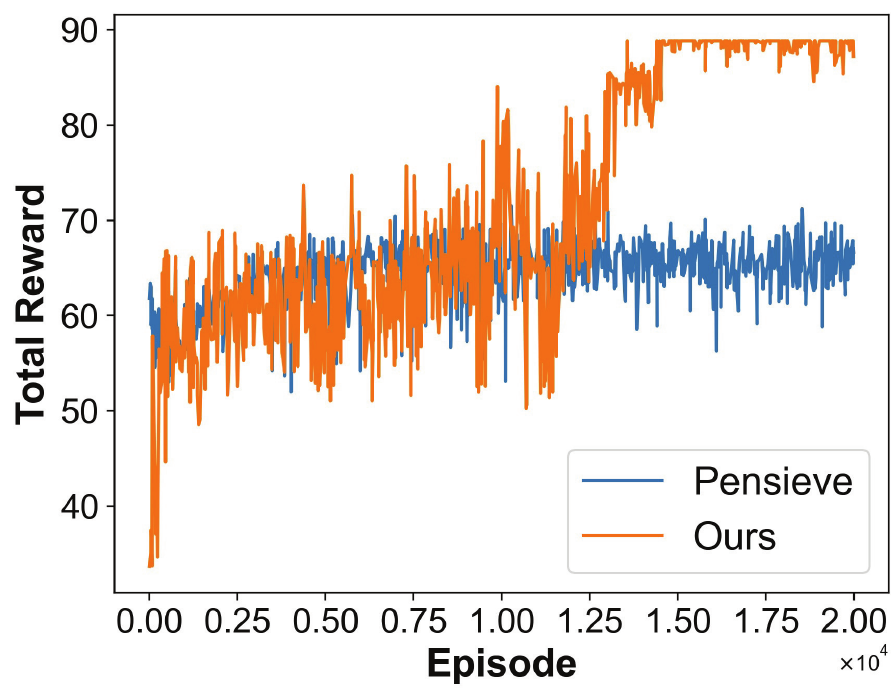
Figure 3. The training processes of our proposed SR-Telemedicine approach and Pensieve. It can be found that both algorithms can be trained to converge.